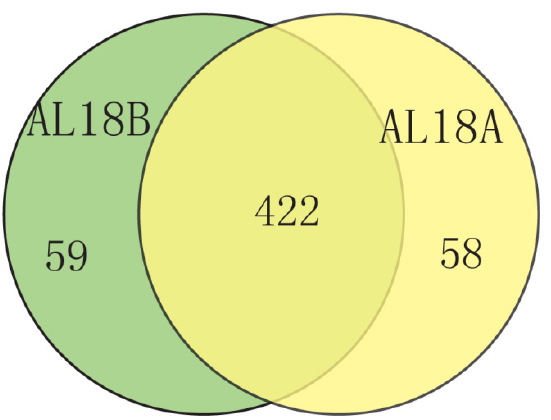
Table 5. Description of eleven orfs containing transmembrane domains in AL18A.